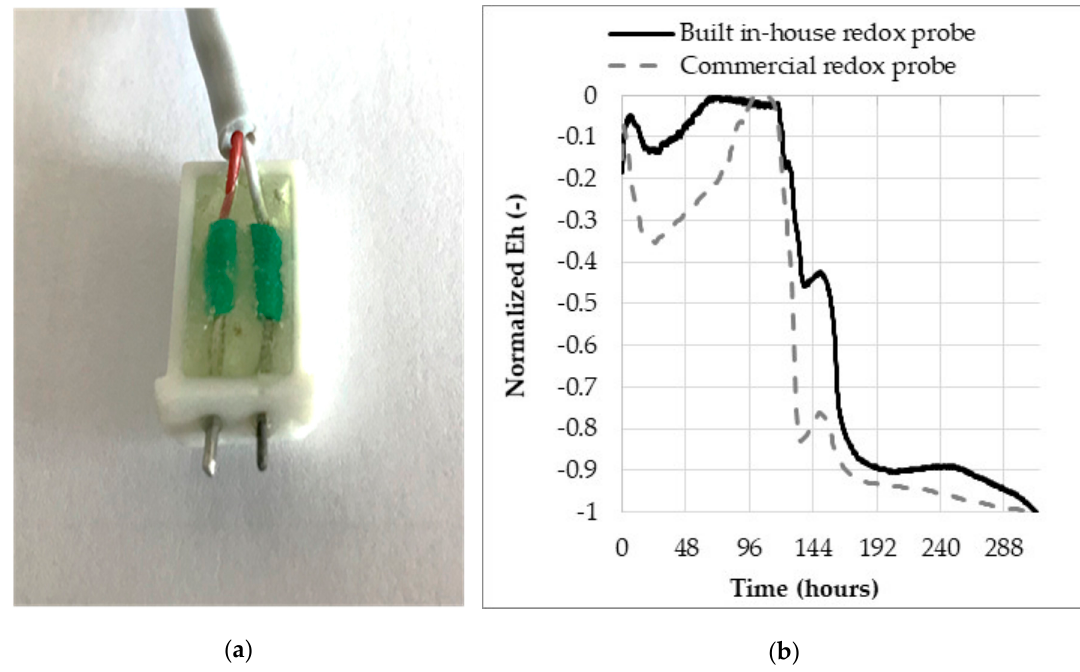
Figure 7. ( a ) Built in-house redox electrode composed of two “working” electrodes of 1 mm in diameter, one of which consists of a platinum rod (left) and the other of an oxidized iron rod (right) molded in a resin; ( b ) Monitoring of normalized E h measured with a commercial redox probe (Hanna Instrument, in grey dashed line) and our built in-house redox probe (in black solid line) in a steak juice diluted 1/5 unfiltered as a function of time.